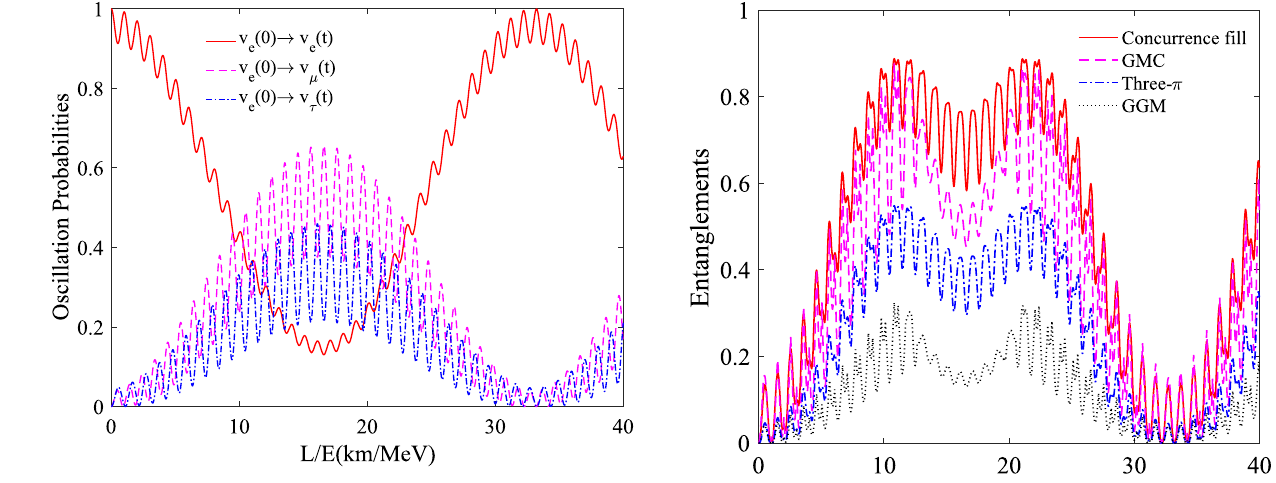
Fig. 1 Oscillation probabilities as a function of the ratio between the traveled distance L and the energy E . The figure plots the oscillation probability v e ( 0 ) → v e ( t ) (red, solid line), v e ( 0 ) → v μ ( t ) (purple, dashed line), v e ( 0 ) → v τ ( t ) (blue, dashed-dotted line) when the initial